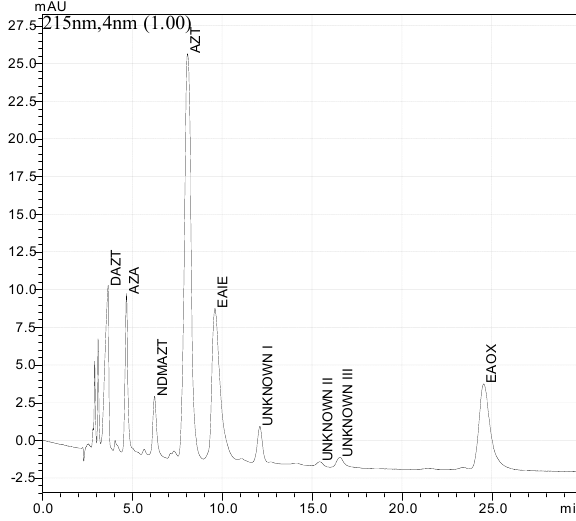
Figure 3. Typical chromatogram of the working mixture obtained under optimized chromatographic conditions.